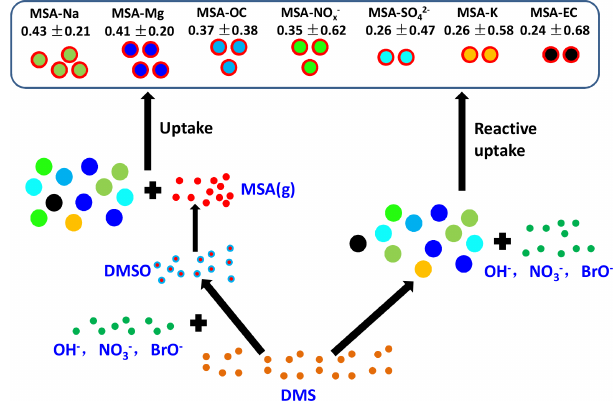
Figure 6. MSA uptake rates for different aerosol particles in the marine